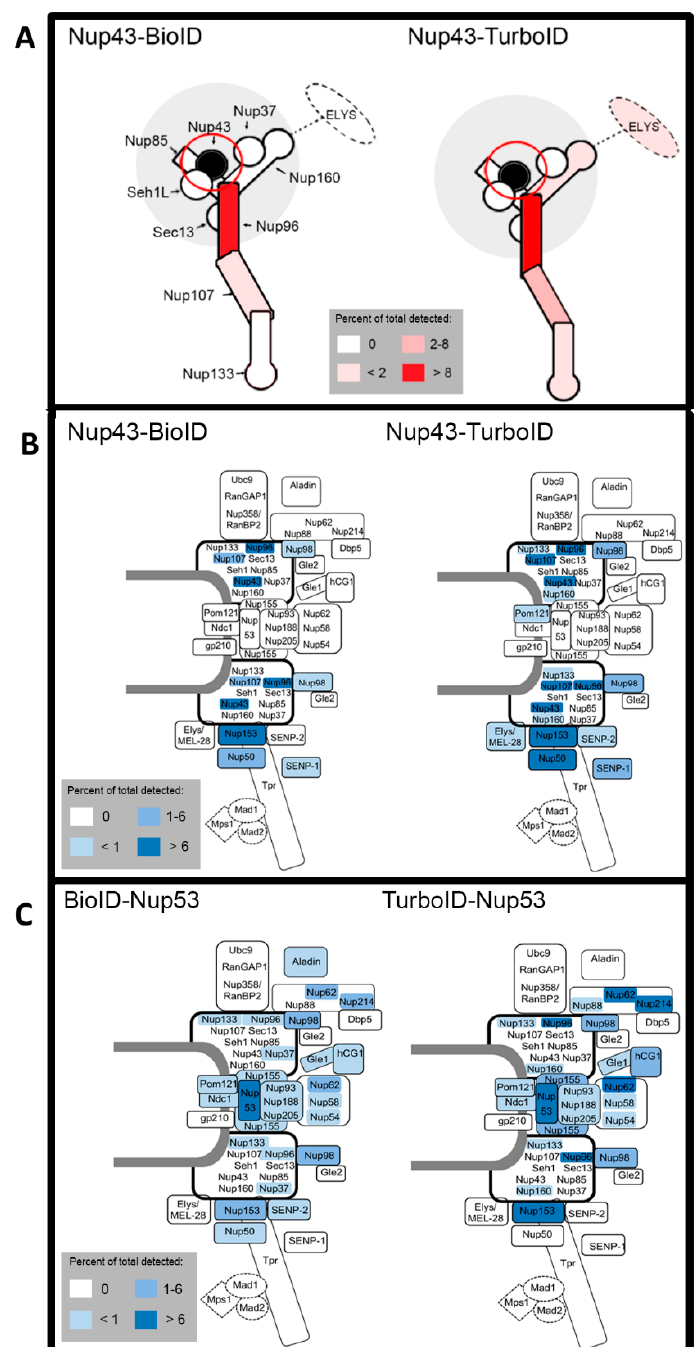
Figure 6. Schematics of practical labeling radii comparisons for Nup43 and Nup53 fusion proteins. ( A ) Schematic of labeling radii of Nup43-BioID and Nup43-TurboID within the Nup107-160 complex. Intensity of red labeling correlates with normalized percent total detected for each identified protein. ( B ) Schematic of labeling radii of Nup43-BioID and Nup43-TurboID within the NPC. Intensity of blue labeling correlates with normalized percent total detected for each identified protein. ( C ) Similar schematic as ( B ) for BioID-Nup53 and TurboID-Nup53.